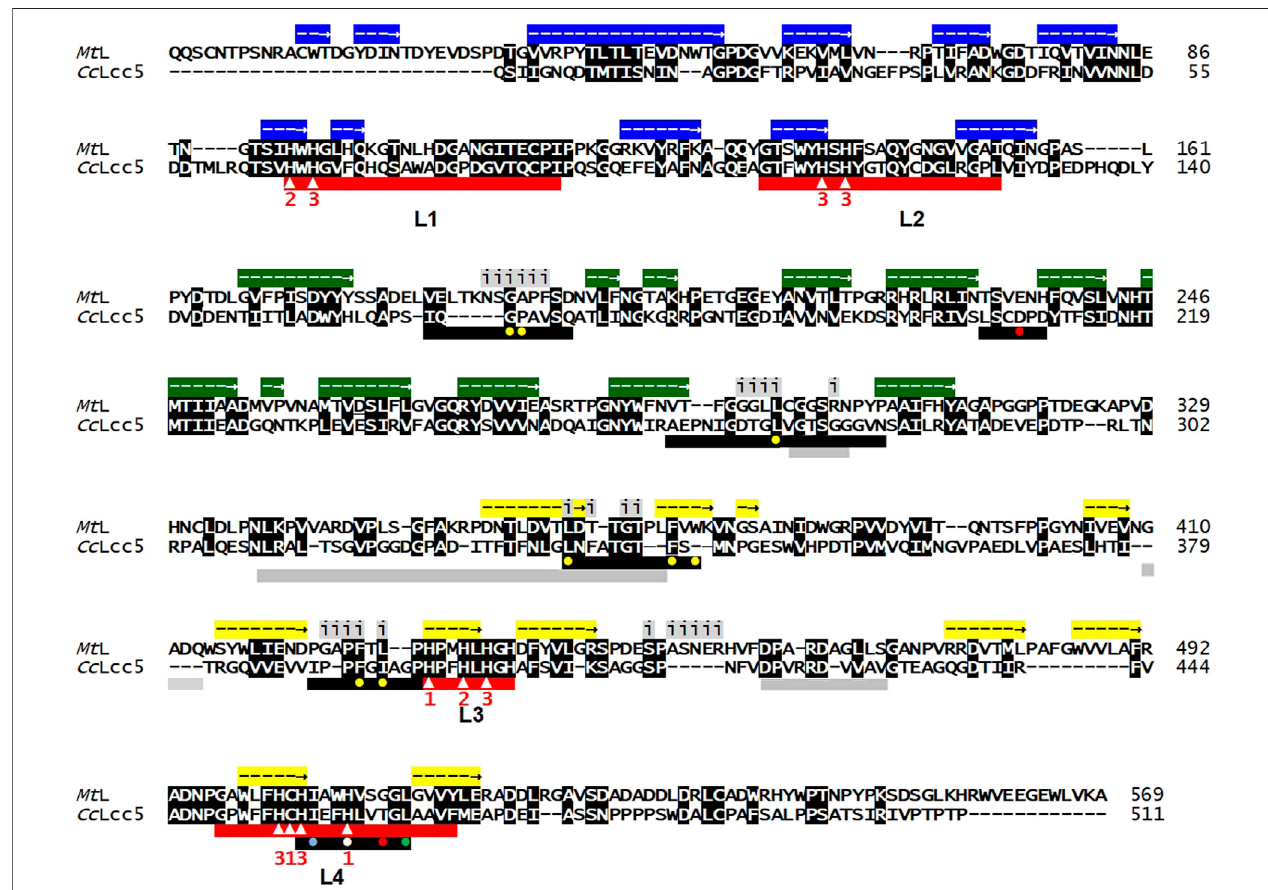
FIGURE 1 | Sequence alignment of asco-laccase Mt L (AEO58496) and basi-laccase Cc Lcc5 (DAA04510). Conserved amino acids are shown with white letters in black boxes. The three cupredoxin-like domains are marked above the Mt L sequence with arrows in colored boxes for extension of their helical structures (blue; cupredoxin-like domain 1; green: cupredoxin-like domain 2; yellow: cupredoxin-like domain 3), according to Ernst et al. (2018). Residues located at the unique dimerizationinterface inthe asco-laccase Mt L aremarkedabove the alignmentwithletter i(for interface) underlain ingrey (Ernst et al., 2018).Red bars beneath the alignments mark the conserved laccase signature sequences L1 to L4, with 10 conserved histidines and a conserved cysteine indicated by white triangles within the bars. Numbers 1, 2, and 3 beneath show the ligands for binding of T1, T2, or T3 copper. Black bars mark the loops forming the substrate pocket in the folded proteins (Hoeggeretal.,2006;Kilaruetal.,2006;KüesandRühl,2011;Ernstetal.,2018).ThehydrophobicresidueLeuinL4,regardedasanindicatorforenzymeswithmedium- redox-potential (Hoegger et al., 2006; Kües and Rühl, 2011), is marked in the black bar by a fi lled green circle. Yellow fi lled circles in black bars stand for hydrophobic residues that line the T1-Cu pocket of Mt L, the white and red fi lled circles for His508 and Glu235 for the polar recognition motif of Mt L for phenolic substrate (DMP) deduced in analogy from the established structure of DMP-bound M. albomyces laccase Ma L, and a light-blue fi lled circle for a further hydrophobic ligand in the sequenceofmotif L4(after Ernstet al., 2018).Grey bars underneath thealignments show sequences fortheproposedalternativebindingsite fornon-phenolicABTSon the surface of folded Mt L with an unusual hole localized 26 Å from the T1-Cu pocket (Ernst et al., 2018) in analogy to Bacillus subtilis CotA laccase (Liu et al., 2016).